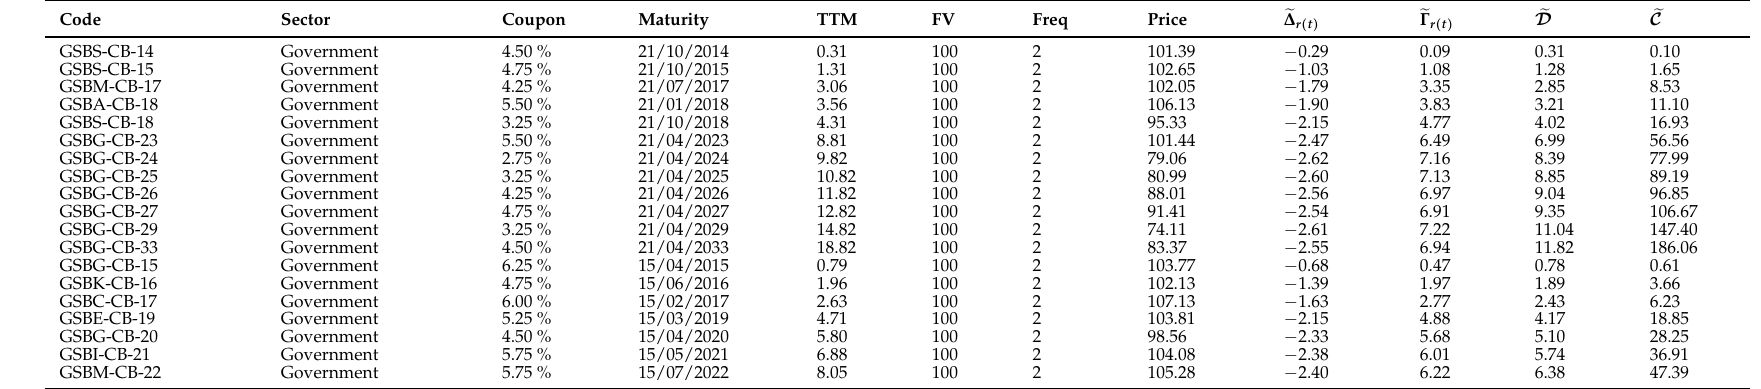
Table 7. These are semi-annual coupon paying bonds available in the bond market. Codes used are those for the ASX. Maturities range up to 18.8 years and Fisher-Weil durations range up to 11.82 years with the longest duration exceeding that of the life annuity. The interest rate deltas range up to 2.62 and are all similar for bonds maturing longer than 4 years. Fisher-Weil convexity varies much more than interest rate gamma across the maturity range of the